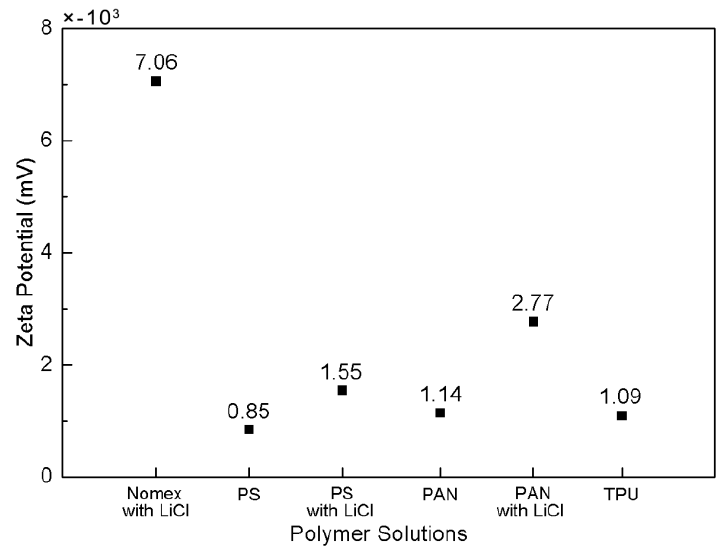
Figure 5. Zeta potential of different polymer solutions.